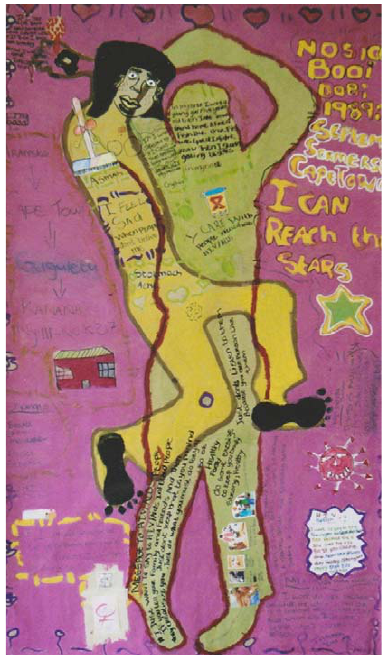
Figure 1. Body mapping. Body mapping is designed to help students negotiate and assert their personal boundaries in relation to their feelings and choices regarding their sexuality. (Photographer Kali van der Merwe.)